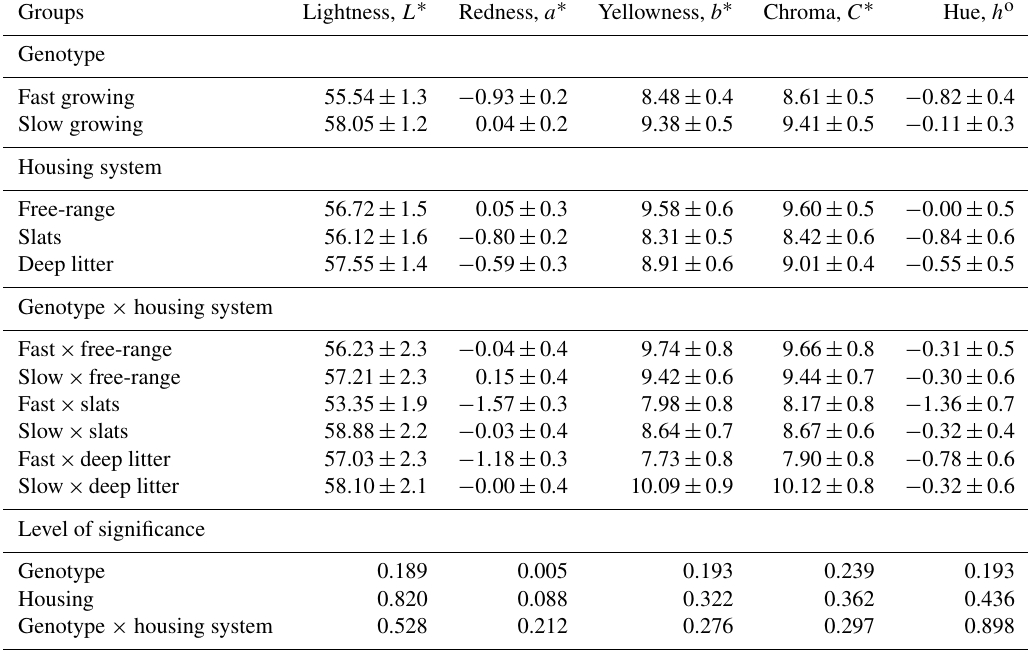
Table 2. Colour values of breast meat collected from slow- and fast-growing broilers raised in three different housing systems (mean ±